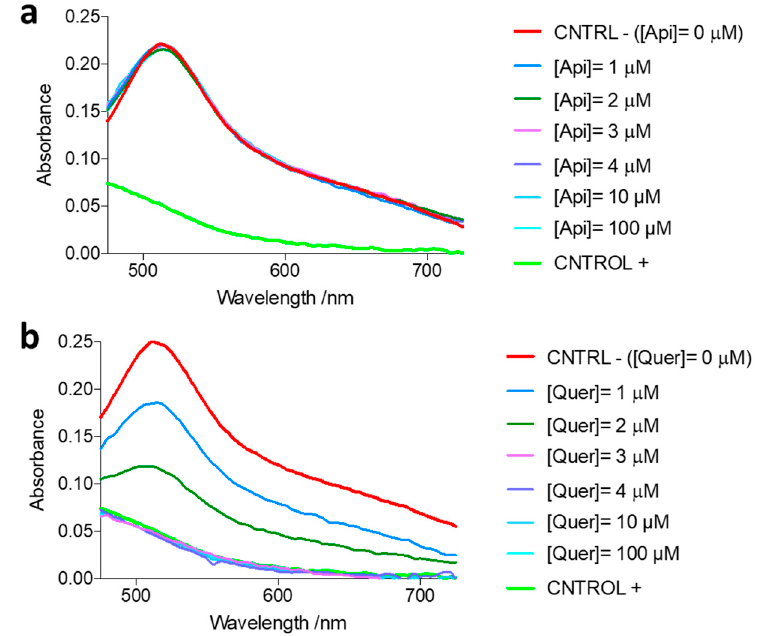
Figure 12. Radical scavenging abilities of ( a ) apigenin and ( b ) quercetin, determined through the absorbance of DPPH at 517 nm, using increasing concentrations of the flavonoids. Table 7. Radical scavenging capacity (RSC, in %) of apigenin and quercetin, determined by their ability to quench the absorbance of the DPPH radical.